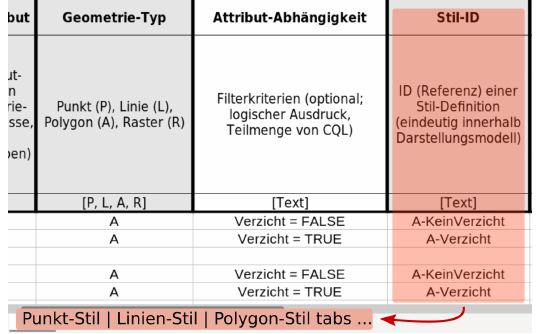
Tiles specification allows for several formats (both vector and raster) to be computed. This way of defining tiles assures on the one hand the compatibility with existing WMTS services